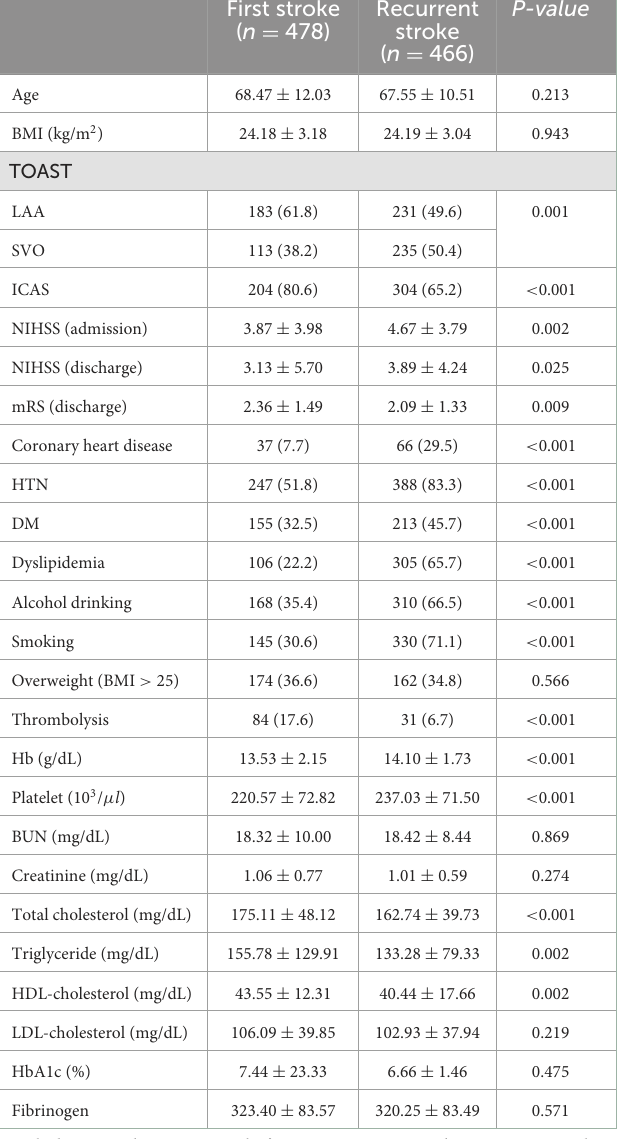
TABLE 2 Comparison of baseline characteristics between first ischemic stroke and recurrent ischemic stroke patients in male